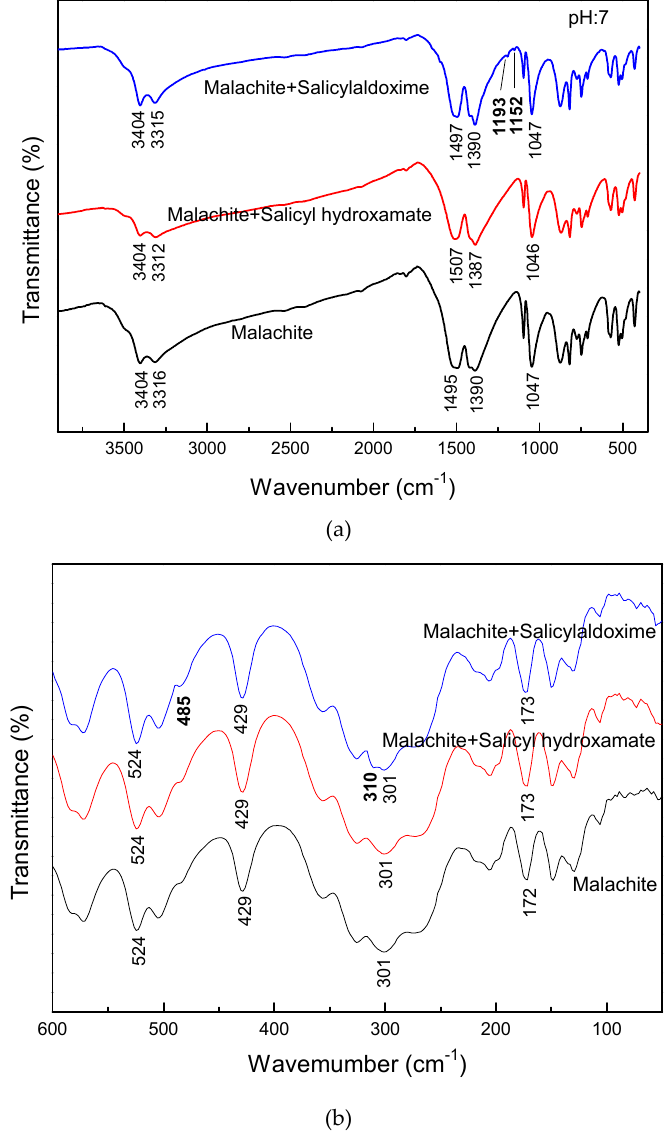
Figure 6. Intermediate ( a ) and far ( b ) Fourier transform infrared (FTIR) spectra of malachite, malachite with salicylaldoxime and salicyl